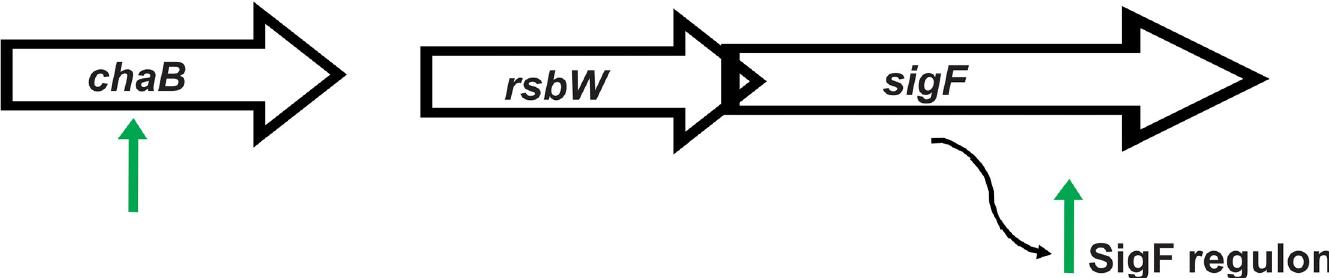
Fig 3. Schematic outlining changes to the expression of chaB and the SigF regulon genes observed in M . smegmatis mc 2 155 Δ phoH2 compared with M . smegmatis mc 2 155 . Green arrows indicate the changes in expression of genes in M . smegmatis mc 2 155 Δ phoH2 relative to M . smegmatis mc 2 155 at 48 hours of growth. The expression of sigF transcript gene chaB and SigF regulon genes increased in the absence of